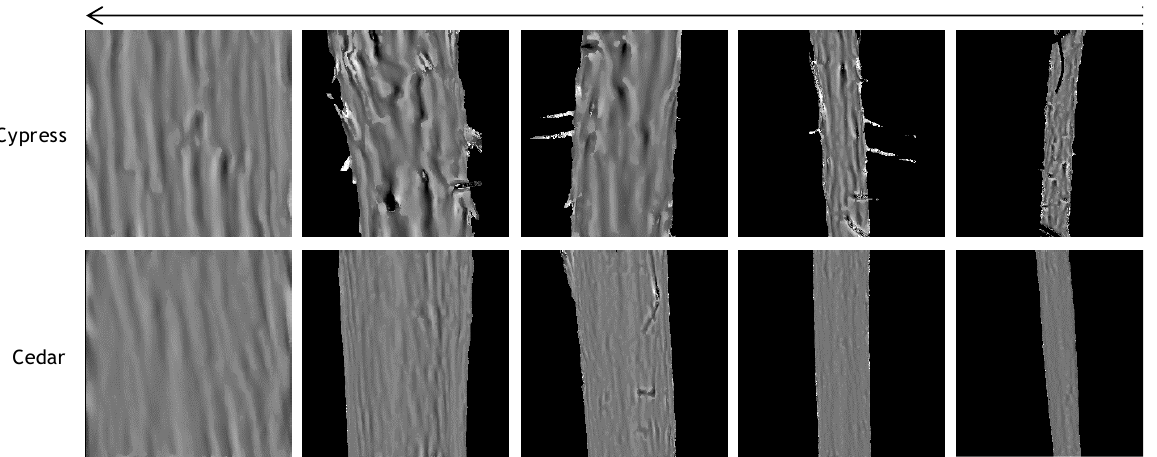
Figure 4. Difference of created curvature images depending on the scanning